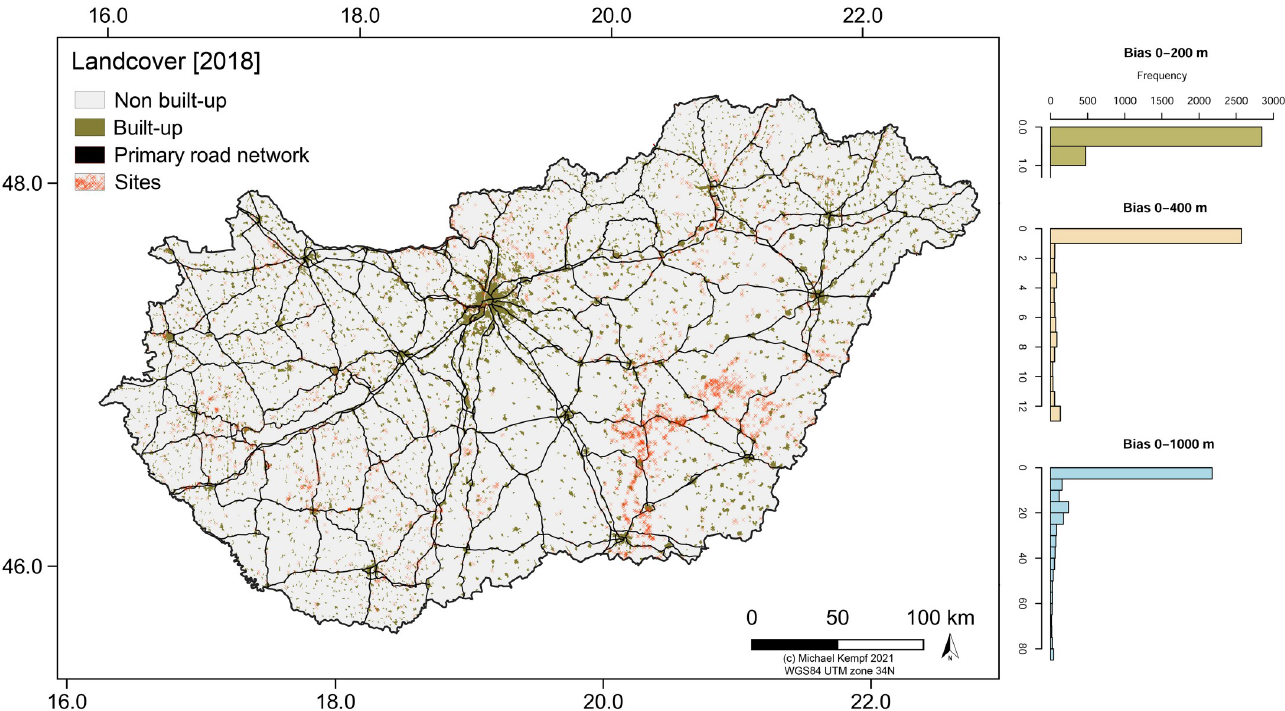
Fig 3. Infrastructural development in Hungary. Built-up and main traffic arteries (highways and 4-lane national roads) in 2018 and the frequency of archaeological sites within 100 (0–200 m), 200 (0–400 m), and 500 m (0–1000 m) radius around the bias surface.